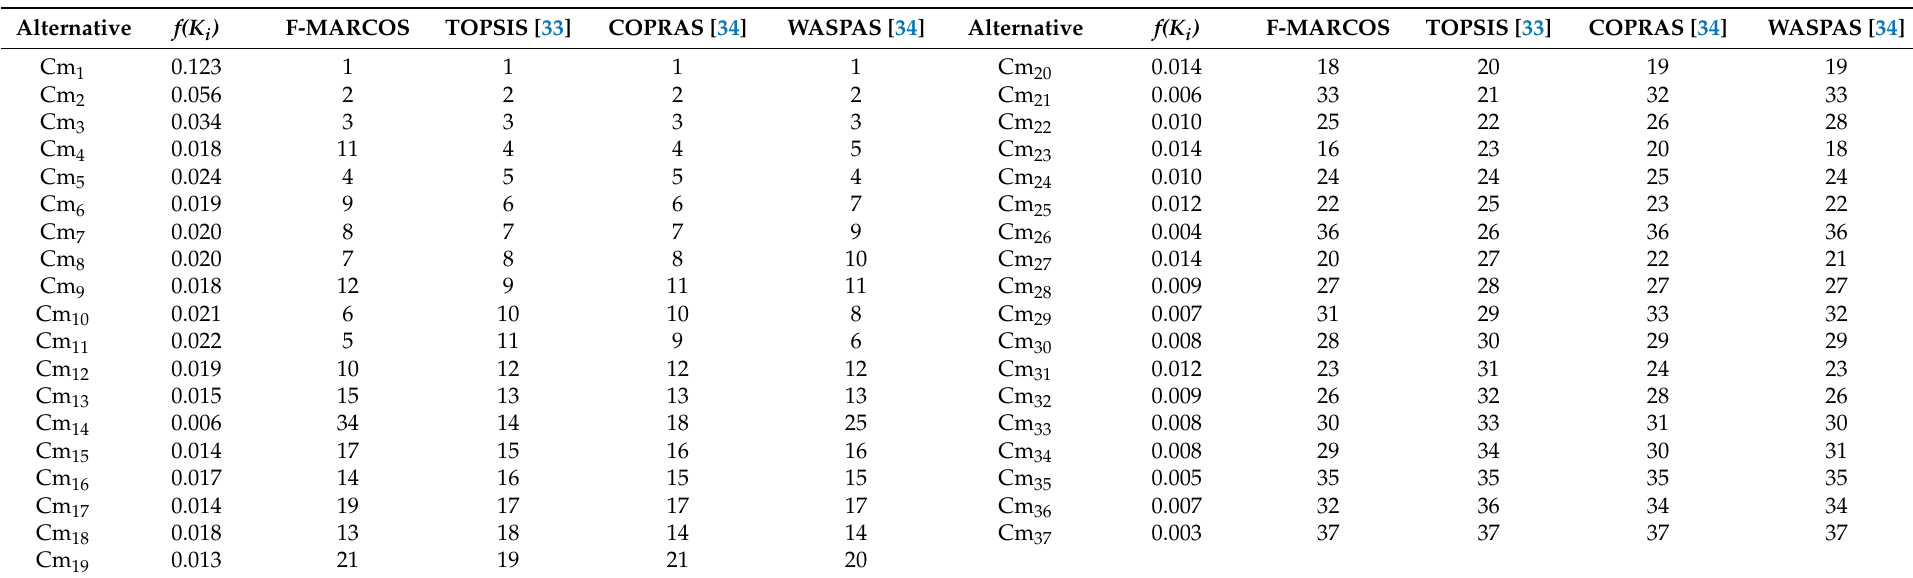
Table 11. The final preference value of alternative and its